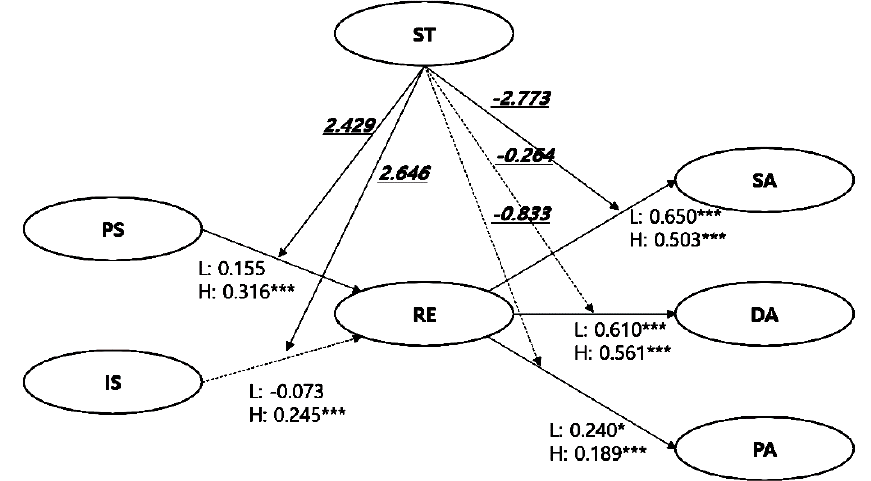
Figure 3. Structural model with standardized path coefficients and composite reliability between low and high groups on social trust. Note: * p < 0.05, *** p < 0.001. DA, distancing activity; IS, individual support; PA, purchasing activity; PS, public support; RE, response efficacy; SA, sanitary activity; and ST, social trust.